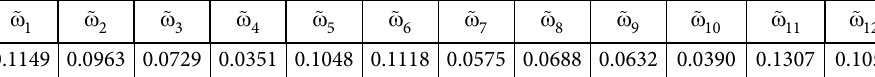
Table 6. Adjusted criteria weights ω  1